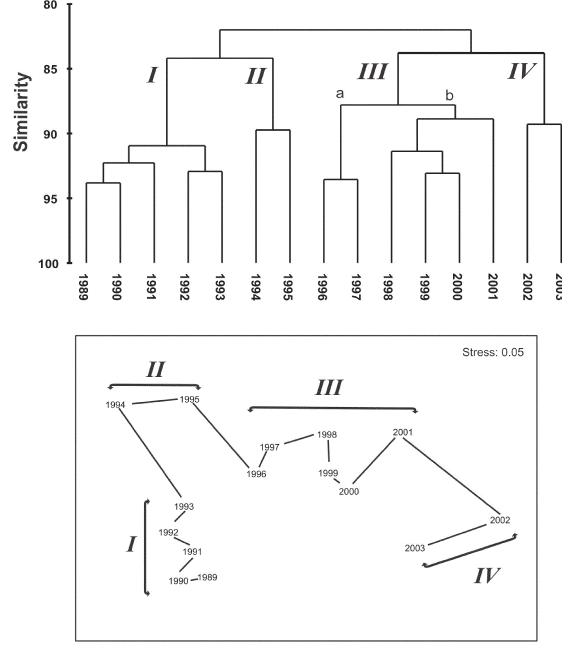
f ig . 3. – dendrogram of the cluster analysis and nMds two dimen- sional diagram showing resulting time